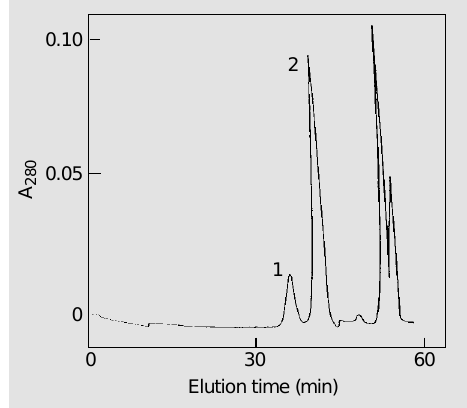
Figure 3 - Fractionation of the reduction and carboxymethyla- tion reaction mixture of cactin on a Superdex Peptide HR 10/ 30 column. 1 and 2, Protein peaks corresponding to large and small chains,